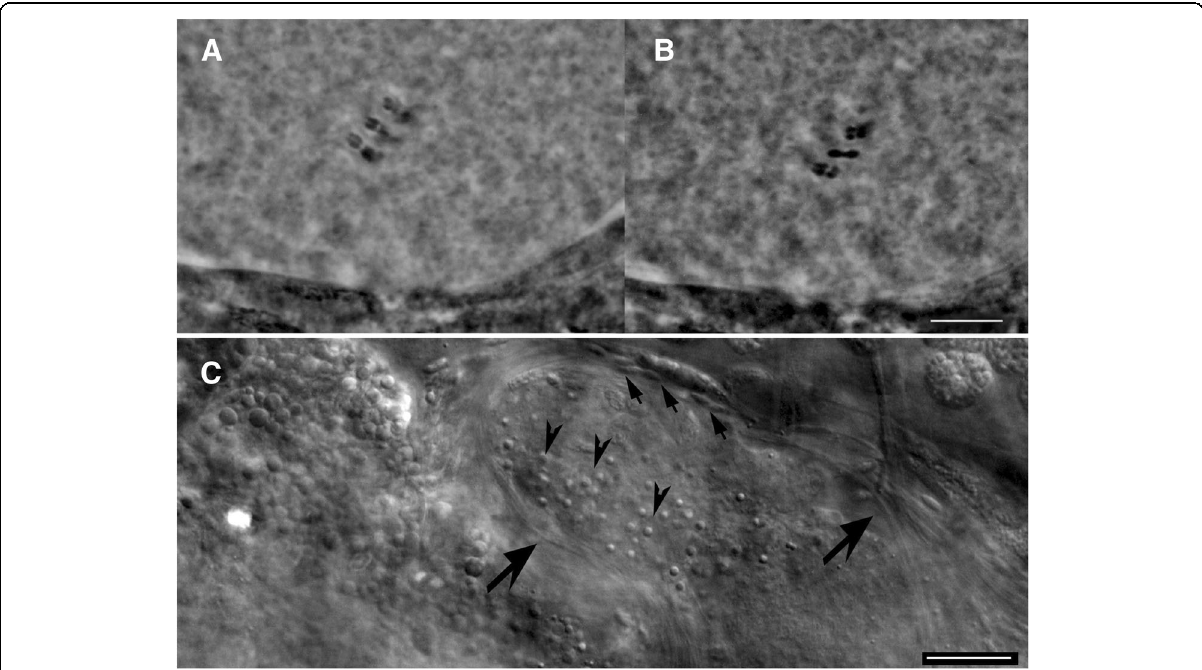
Fig. 3 Paramacrobiotus richtersi from type locality (Clare Island). a and b Six bivalents in an oocyte in different focal planes (orcein; PhC). c Testis in vivo with spermatids (arrowheads) and spermatozoa (arrows) (DIC). Bars = 10 μ